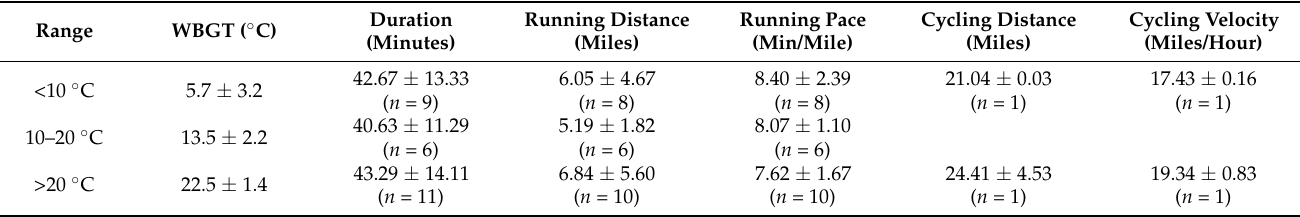
Table 1. Differences in duration, distance, pace, and Wet-Bulb Globe Thermometer between temperature ranges. (mean ± stdev).